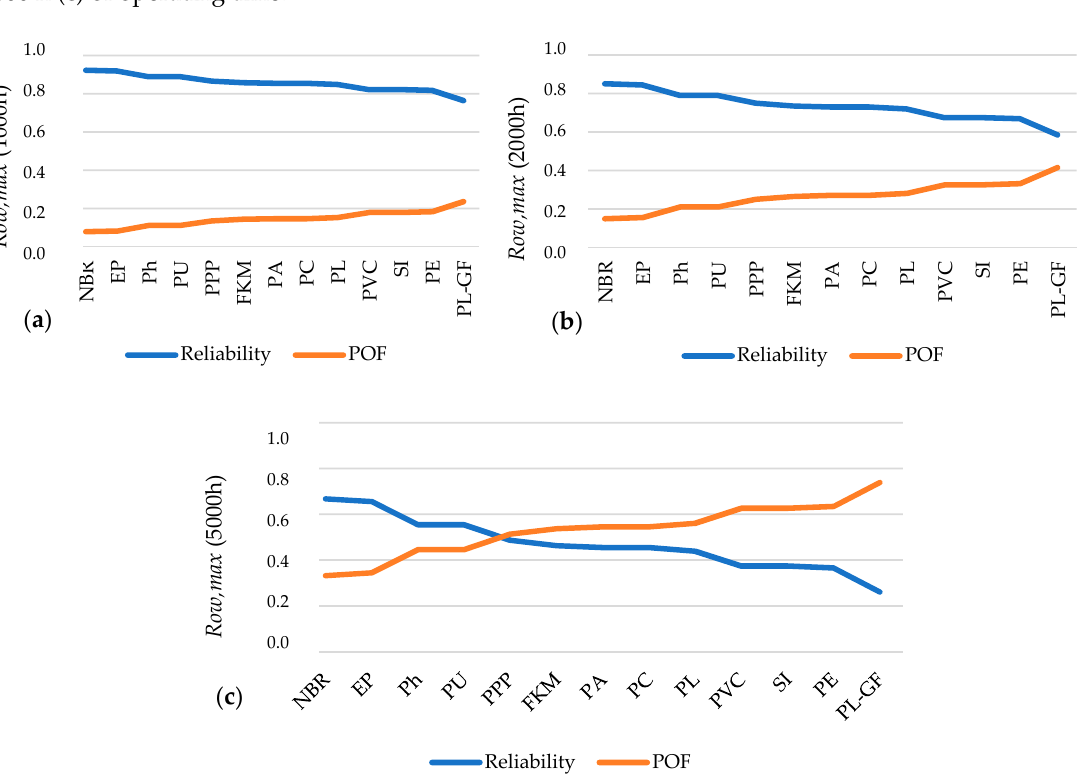
Table 5. λ OW,max and λ Tmax calculation.